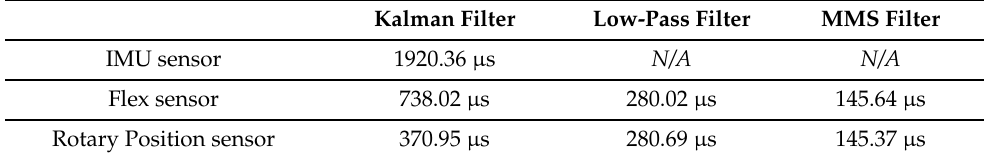
Table 2. Comparison of processing delay of the proposed glove with conventional